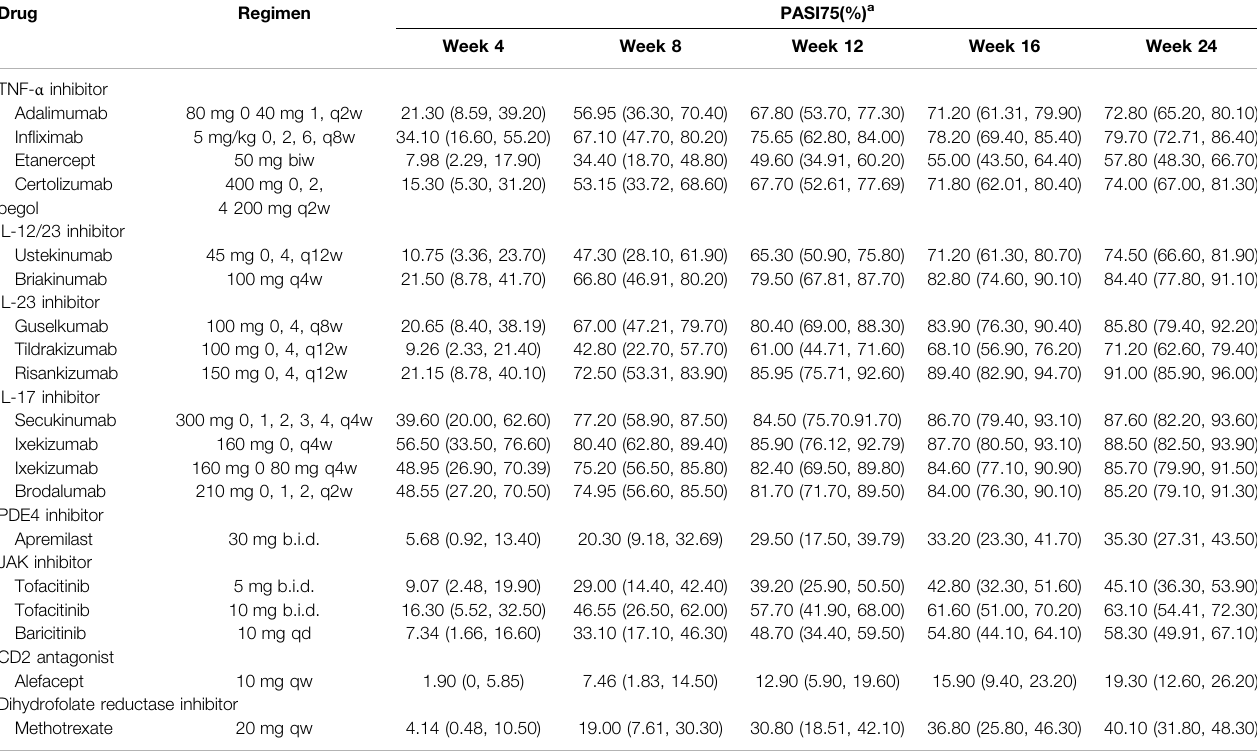
TABLE 3 | Model predicted PASI75 response of treatments at different time points.